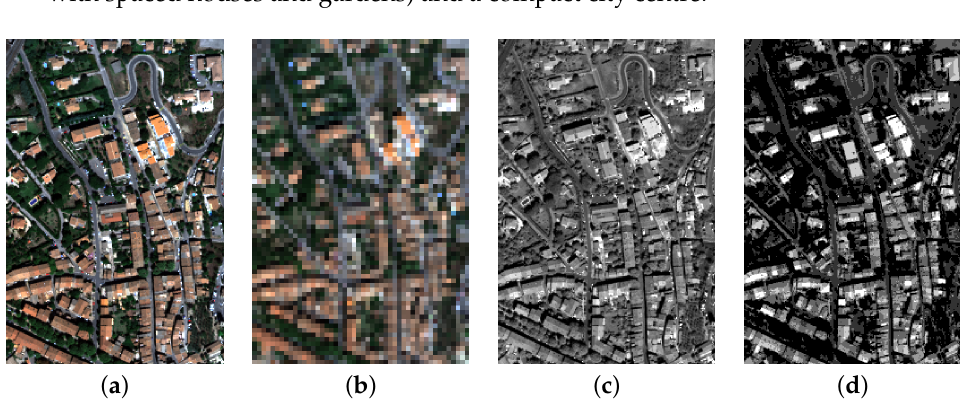
Figure 7. “Gardanne” dataset (spatial resolutions in brackets; RGB representation for HS images). ( a ) REF (1.5 m), ( b ) HS (6 m), ( c ) PAN, visible (1.5 m), and ( d ) PAN, SWIR (1.5